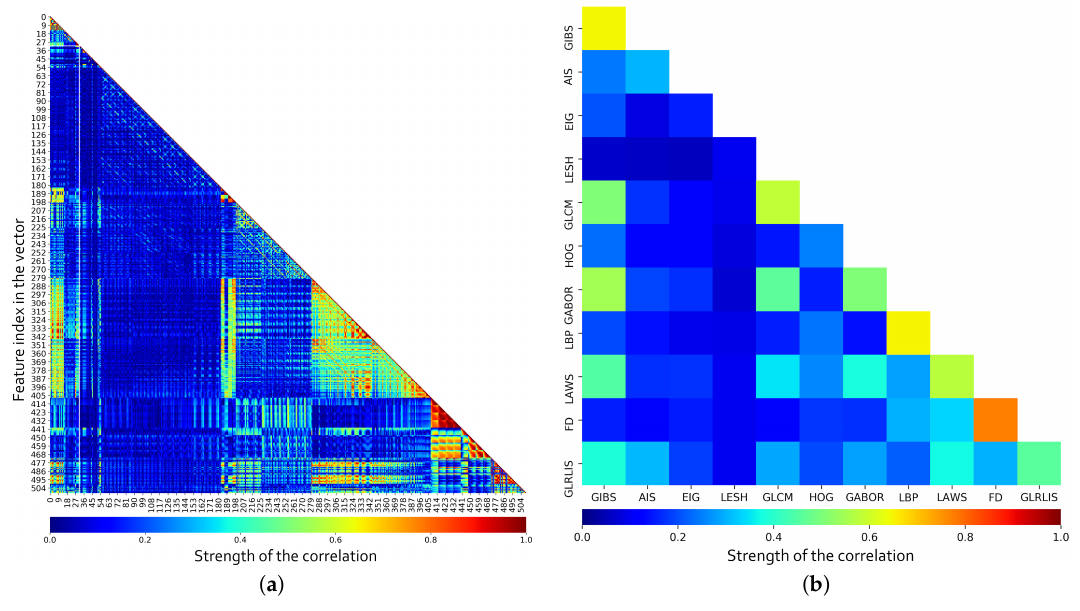
Figure 7. Pairwise correlation for each individual marker in the feature vector ( a ) and mean correlation by feature class ( b